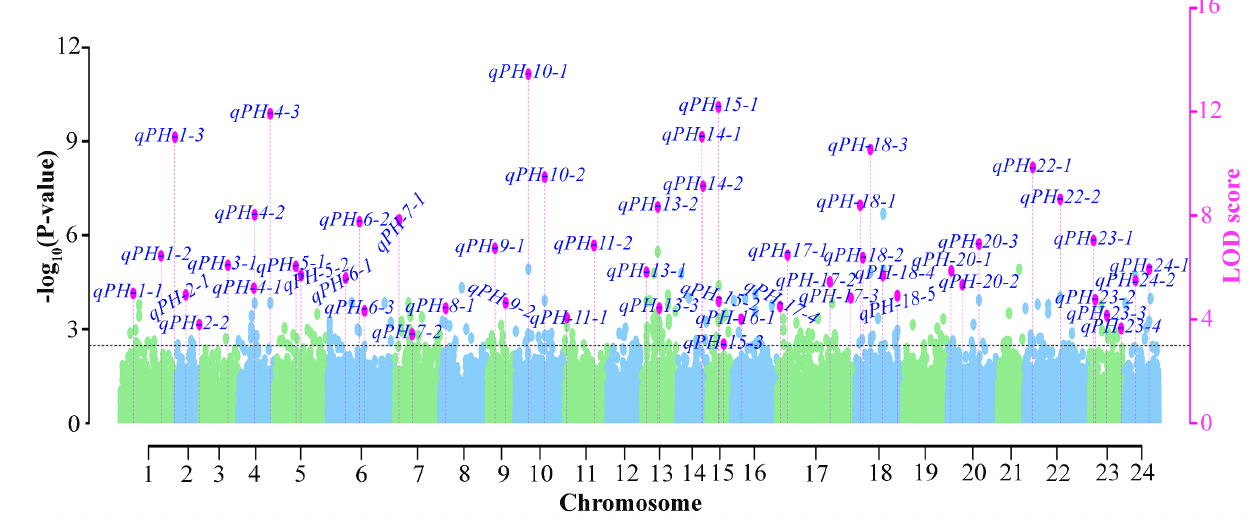
Figure 4. Manhattan plot of association mapping of plant height in tobacco. The figure shows significant and stable QTNs identified in four environments and their BLUP values. The pink dots indicate significant QTNs in ML models, while green and blue dots represent –log 10 p- values in the first step. The dashed line marks the LOD threshold. Table 2. Number of stable QTNs detected in multiple environments for plant height in